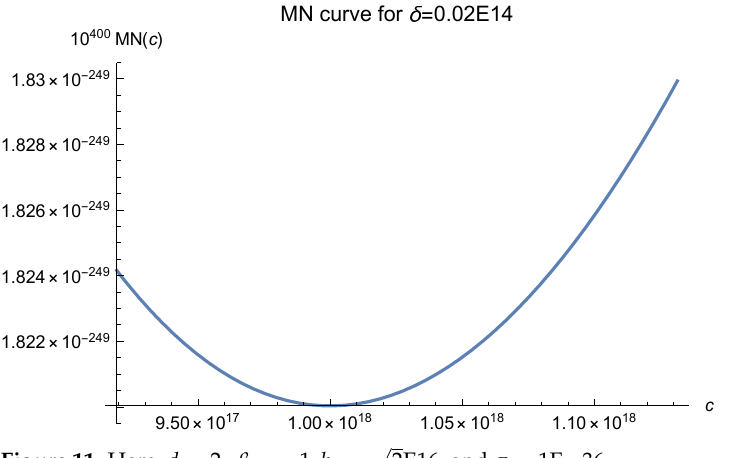
Figure 11. Here, d = 2, β = − 1, b 0 = All these curves show that one should choose c = 7000 ×